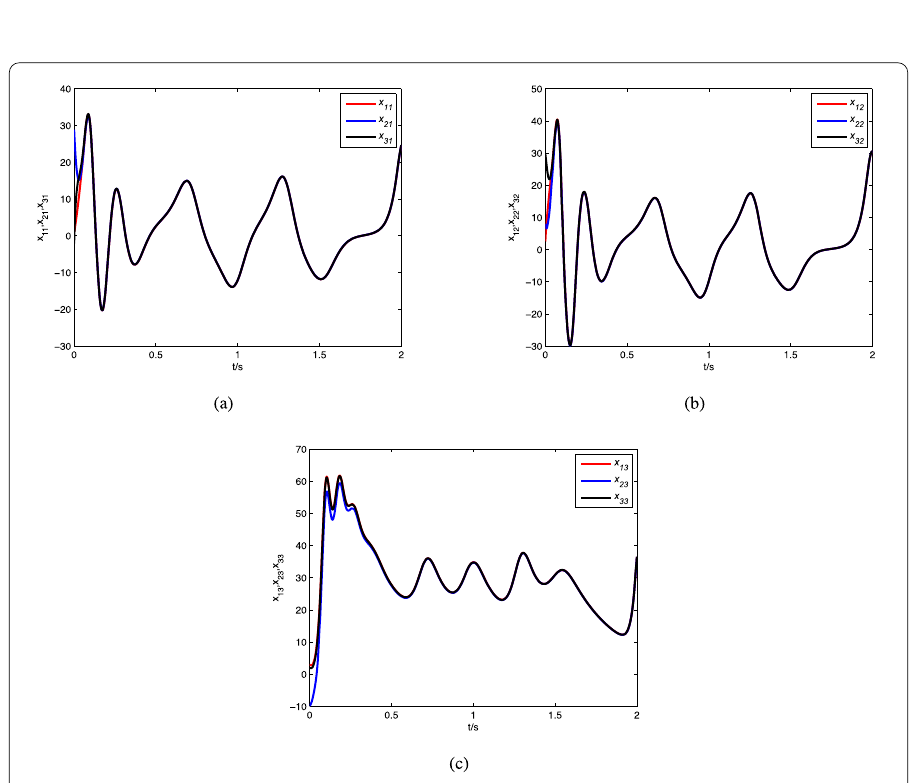
Figure 3 The state trajectories x i 1 , x i 2 , and x i 3 ( i = 1,2,3) of the fractional-order Lü